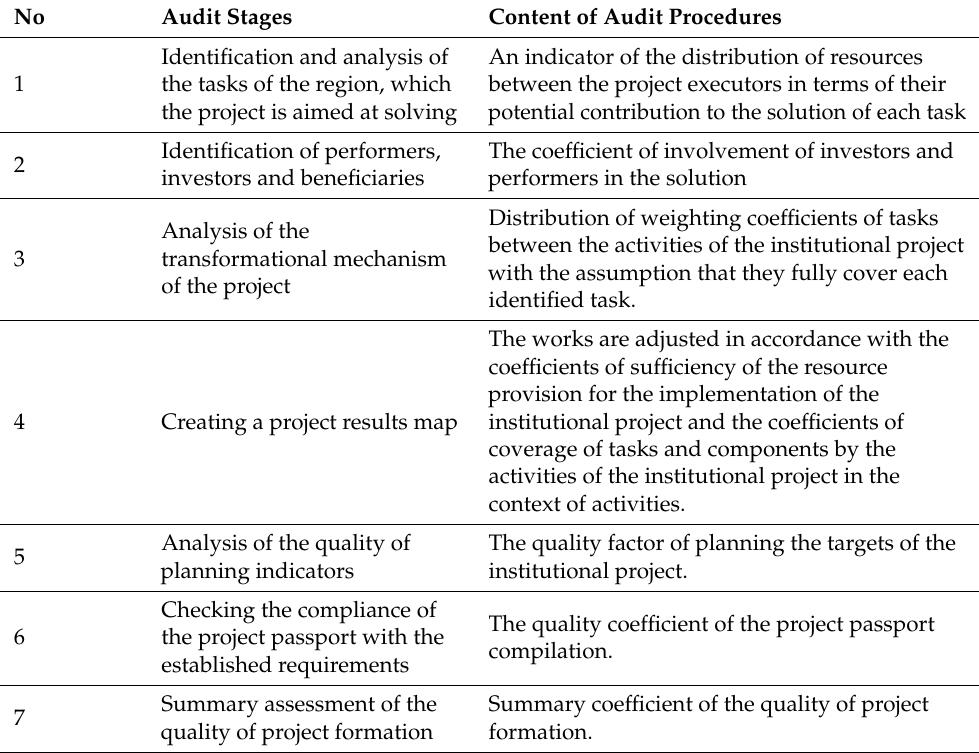
Table 1. Audit of the formation of an institutional